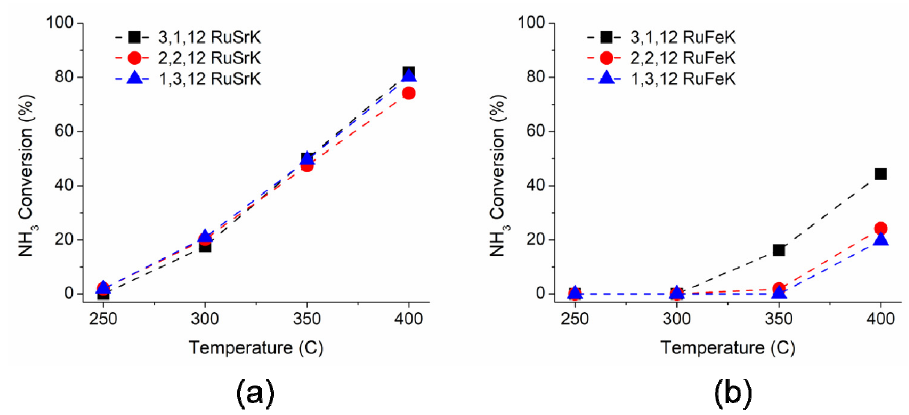
Figure 7. Ammonia decomposition activity of ( a ) 3,1,12 RuSrK, 2,2,12 RuSrK, and 1,3,12 RuSrK and of ( b ) 3,1,12 RuFeK, 2,2,12 RuFeK, and 1,3,12 RuFeK. Reaction conditions: 100% NH 3 , 1.01 bar, and 5400 mL/hr/g cat .